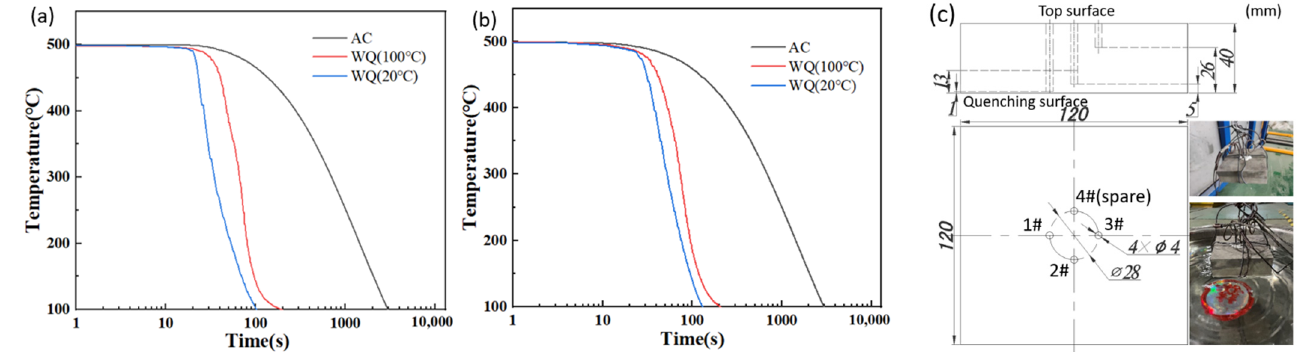
Figure 13. Measured cooling curves in AC, WQ (100 °C) and WQ (20 °C) ( a ) in the 1 mm deep (1#) ( b ) middle part (3#) of the sample by the lumped heat capacity method ( c ) sample of heat transfer coefficient experiment.